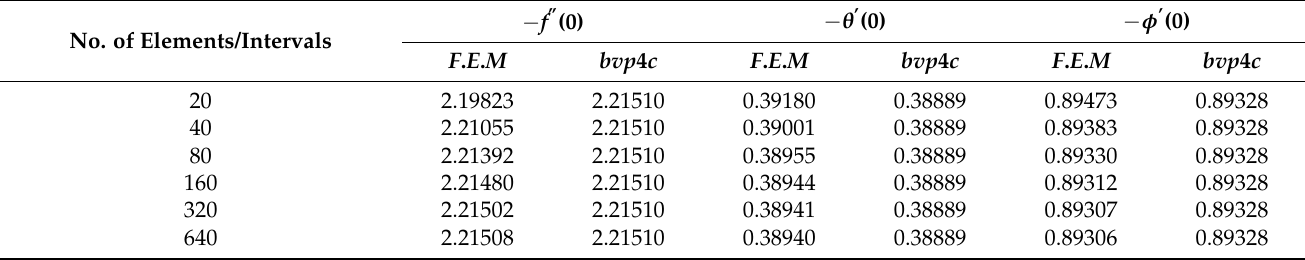
Table 2. Grid independence test using M = 0.5, λ = 0.1, F r = 0.1, P r = 0.9, S c = 0.9, E c